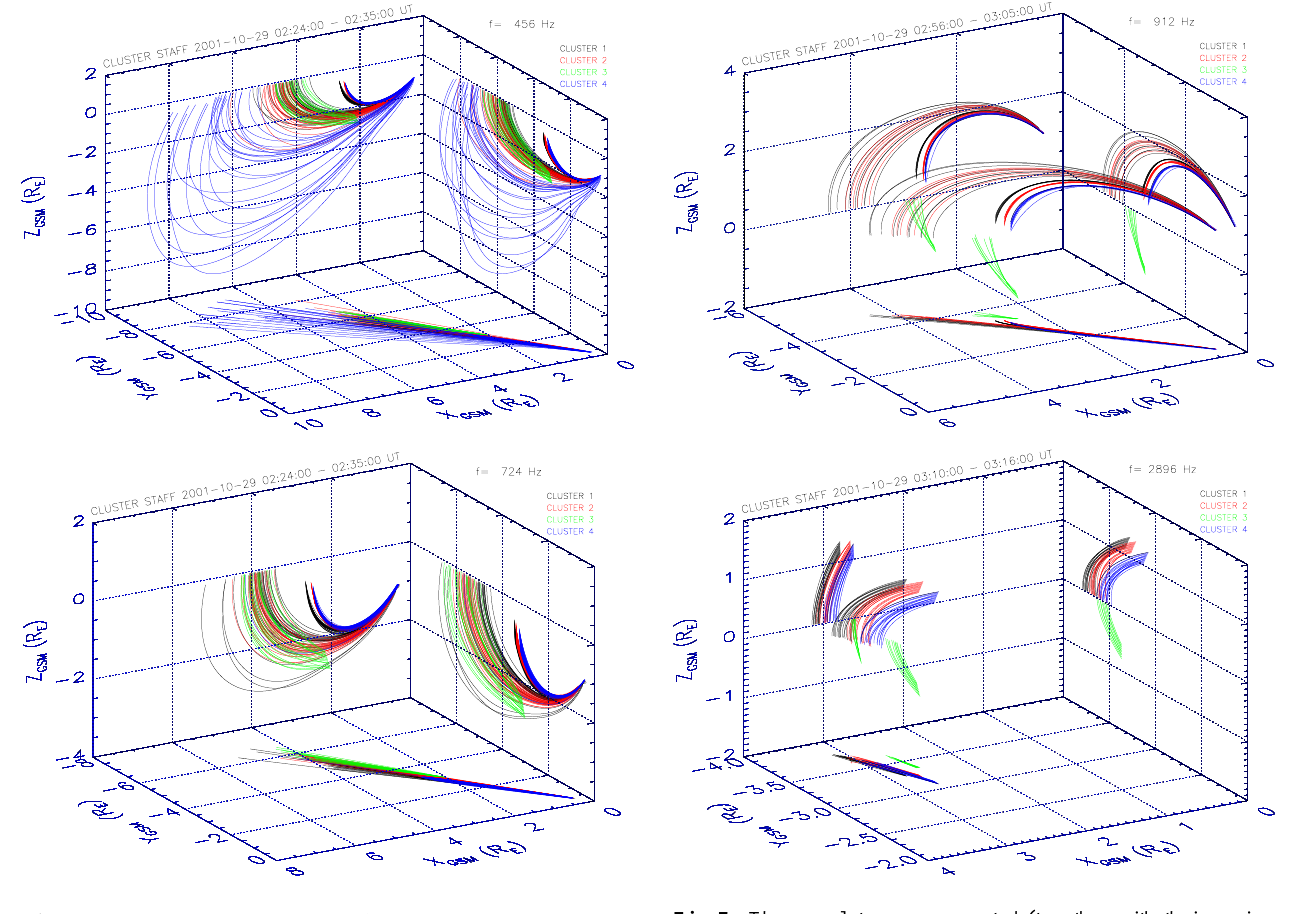
Fig. 6. Same as the bottom panel of Fig. 5, but the top and the bottom panels correspond to 456 and 724Hz, respectively.